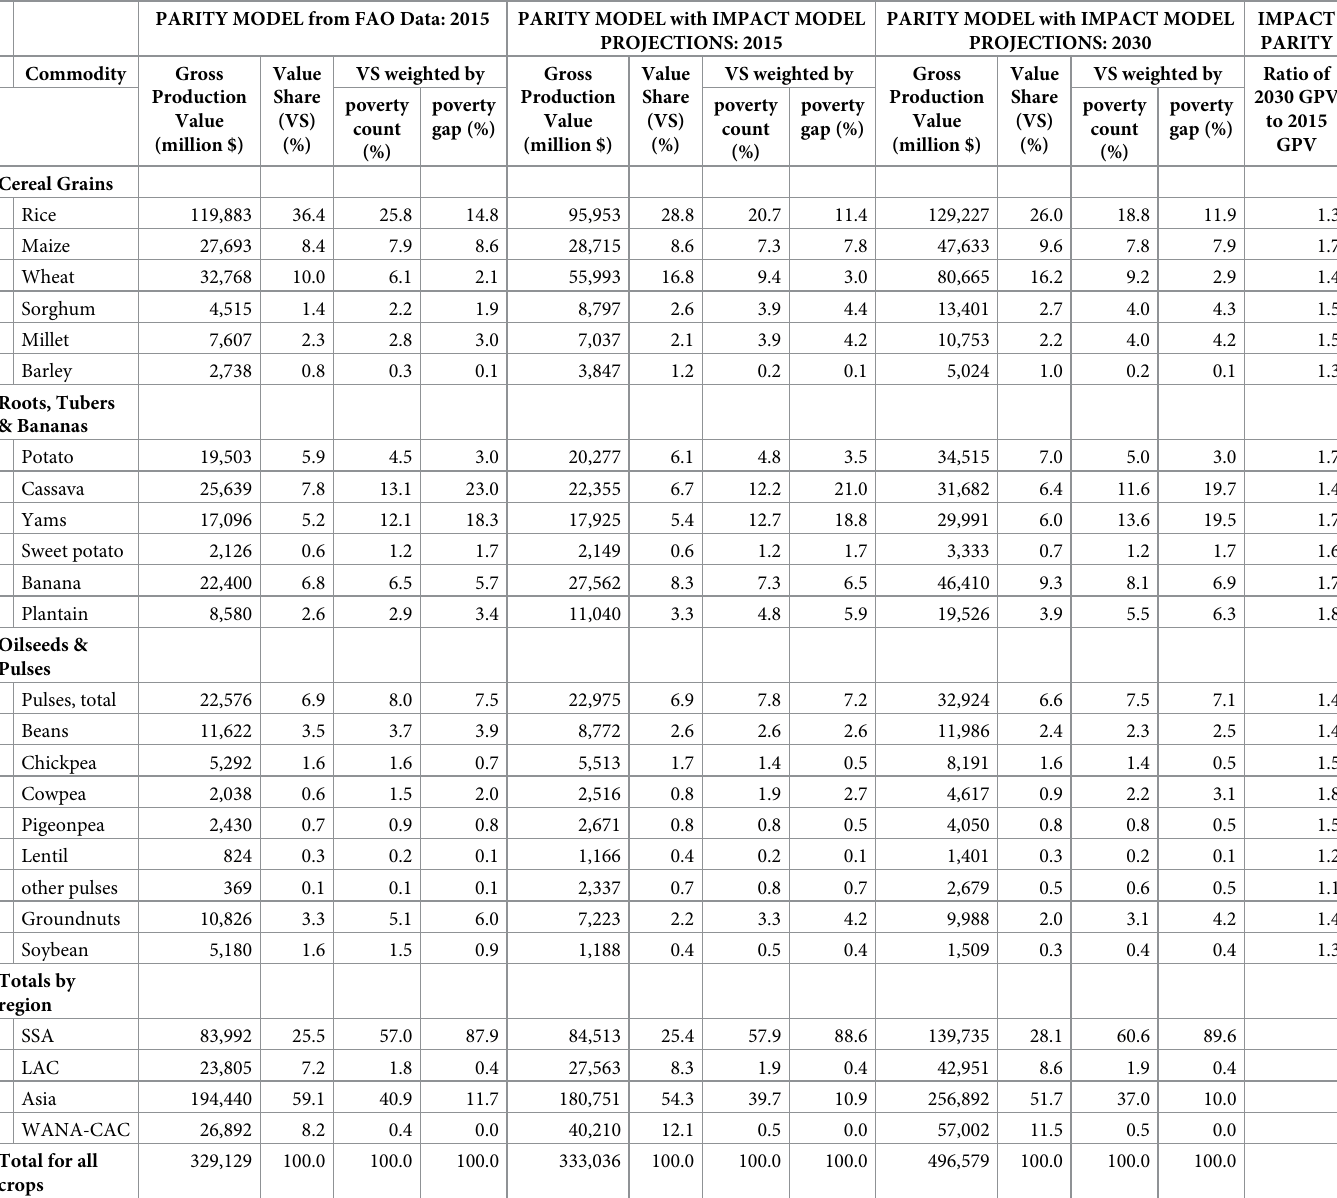
Table 3. Parity model results: Gross production value from FAOSTAT in 2015, and as modeled by the IMPACT model for 2015 and 2030. PARITY MODEL from FAO Data: 2015 PARITY MODEL with IMPACT MODEL